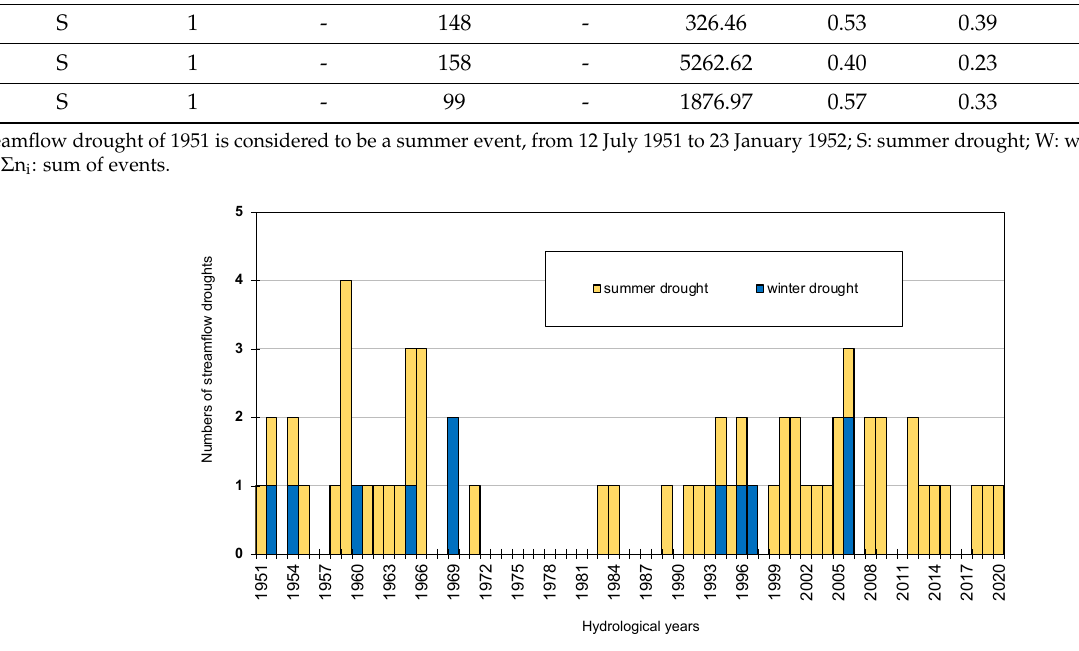
Figure 13. Number of streamflow droughts in the hydrological years 1951–2020 in the Narewka River to Narewka gauging profile; Annotation: the streamflow drought of 1951 is considered to be a summer event.